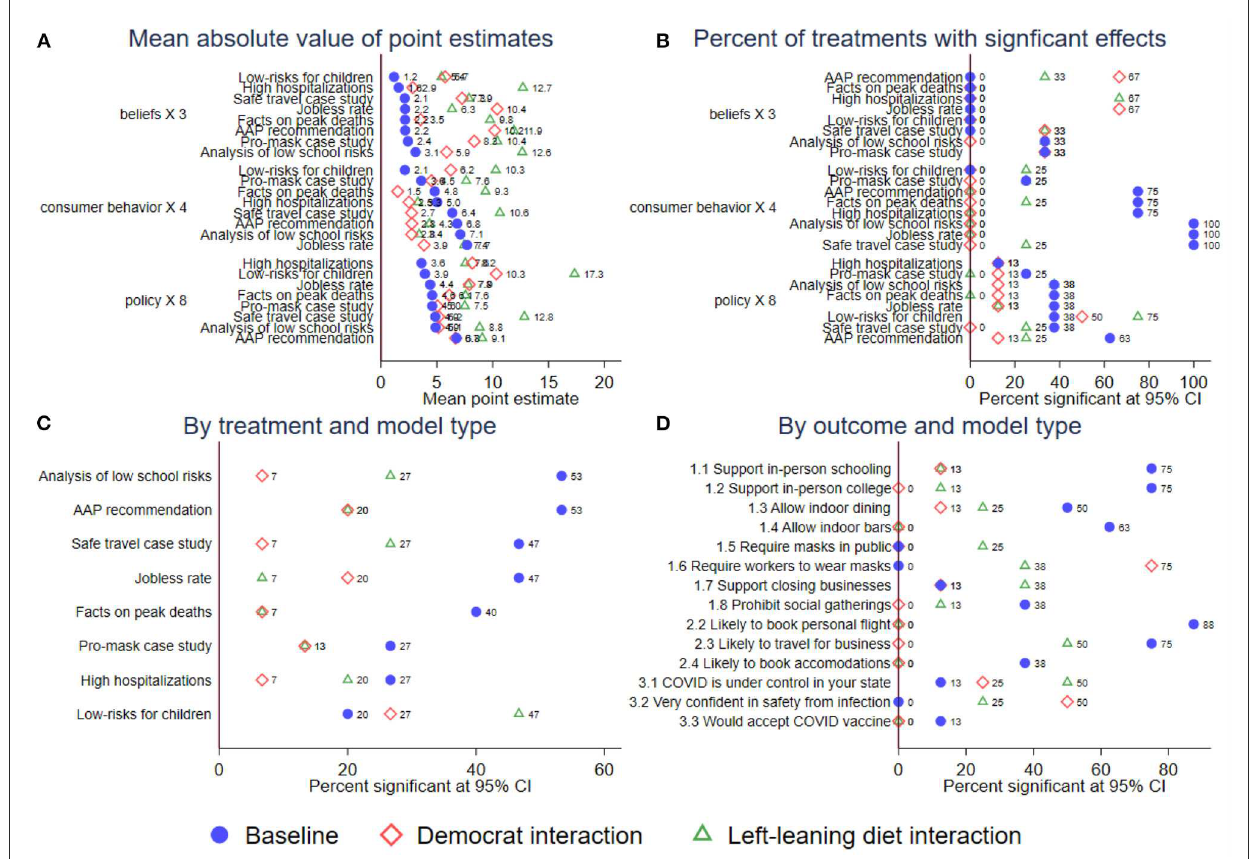
FIGURE4 Meta-analysis of treatment effects across model types. Each figure plots meta-data from our baseline model with the full set of controls and no interactions, a model that includes an interaction term for Democrats relative to Republicans, and a model that includes an interaction term for consuming a liberal-leaning diet relative to a right-leaning diet. (A) shows the mean point estimate for each experimental group organized by the three outcome types. (B) show the percentage of treatment effects reaching significance thresholds with 95% confidence intervals for each experimental group organized by the three outcome types. (C) shows the percentage of treatment effects reaching significance thresholds with 95% confidence intervals for each experimental group, aggregated across all treatment. (D) shows the percentage of treatment effects reaching significance thresholds with 95% confidence intervals for each experimental group, aggregated across all